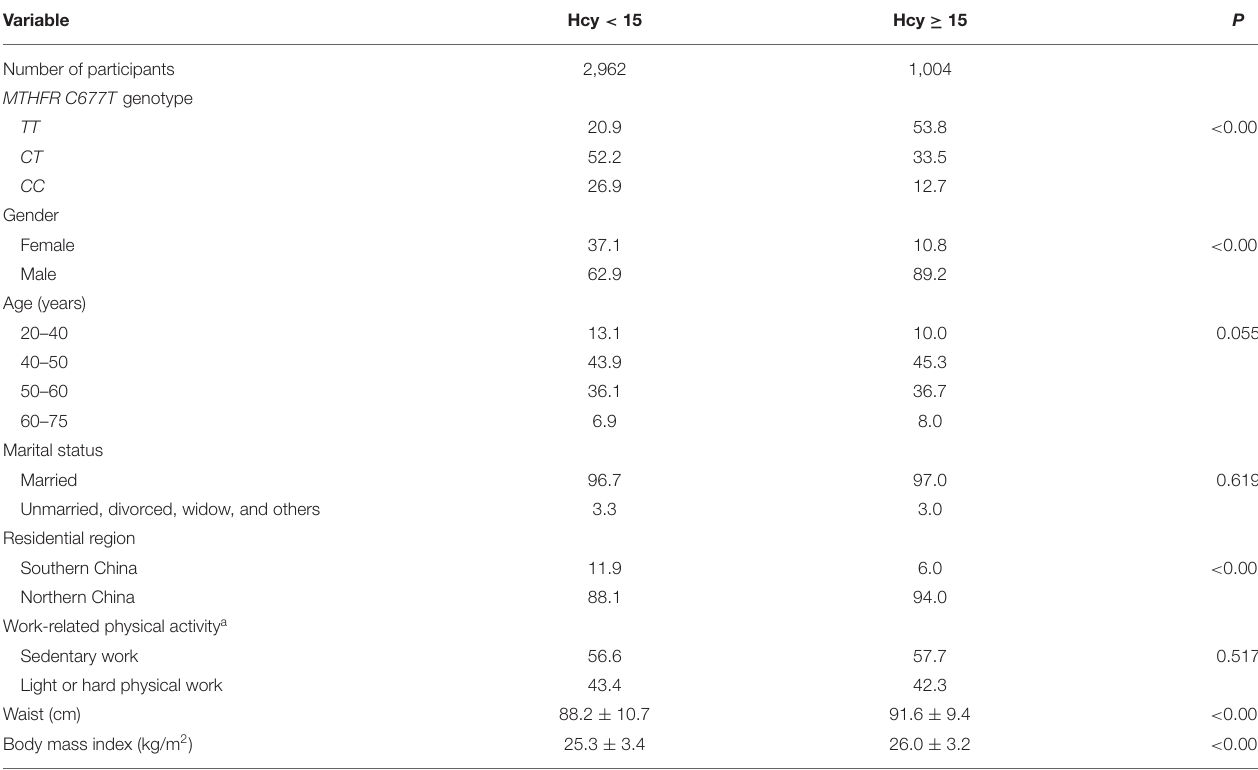
TABLE 1 | Differences in the general characteristics between participants with and without hyperhomocysteinemia. Variable